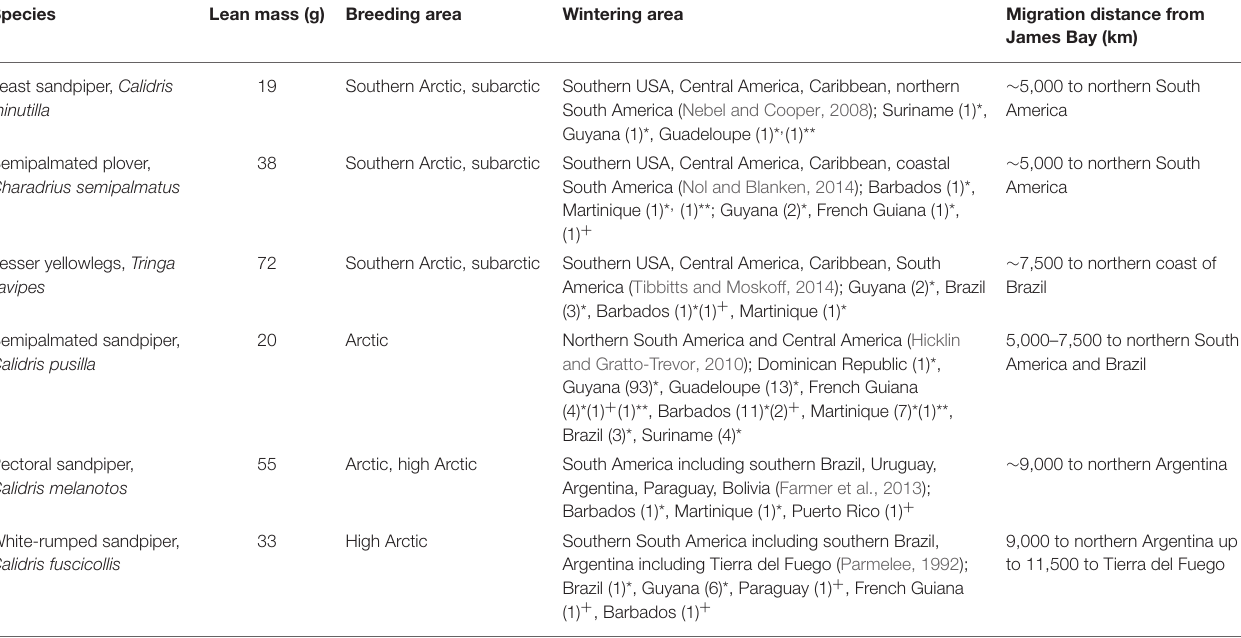
TABLE 1 | Migration characteristics of shorebirds stopping at James Bay, Ontario, Canada, on southbound migration. Species Lean mass (g) Breeding area